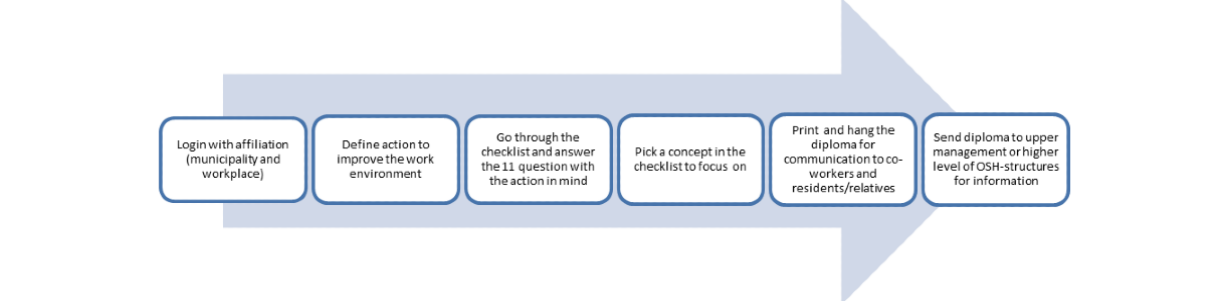
Figure 2. Overview of the steps on the Web-based